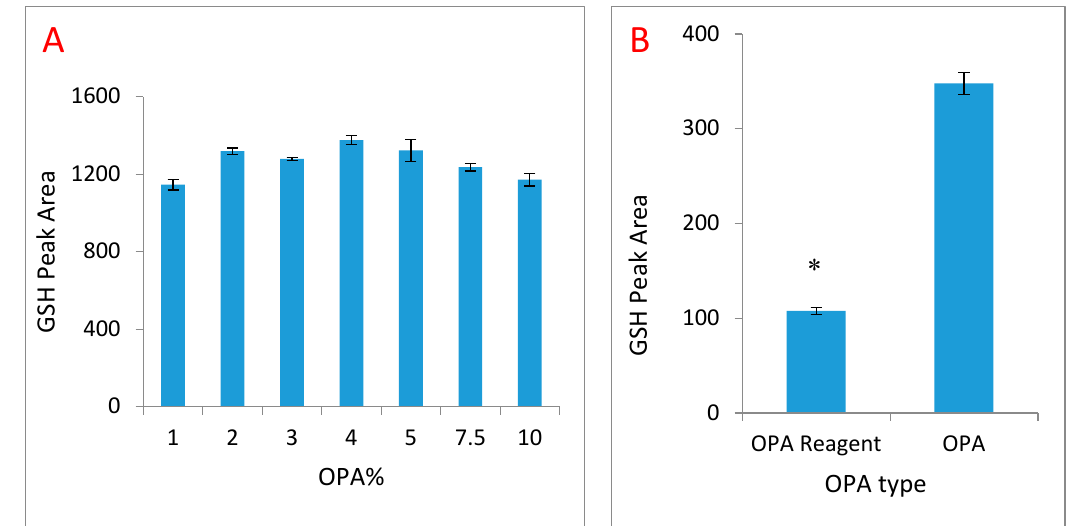
Figure 2. ( A ) Summary figure of the optimisation of glutathione-O-pthaldialdehyde (OPA) concentration using a 2000µM reduced glutathione (GSH) standard. ( B ) Reactivity of OPA and OPA reagent with 400 µM GSH standard. Data are presented as mean ± (standard error of mean (SEM) ( n = 5, * p < 0.05). Standards prepared using N-ethylmaleimide (NEM) and incubated for up to 10 min and assayed by high performance liquid chromatography (HPLC). Peak areas at a wavelength of 450 nm were measured.